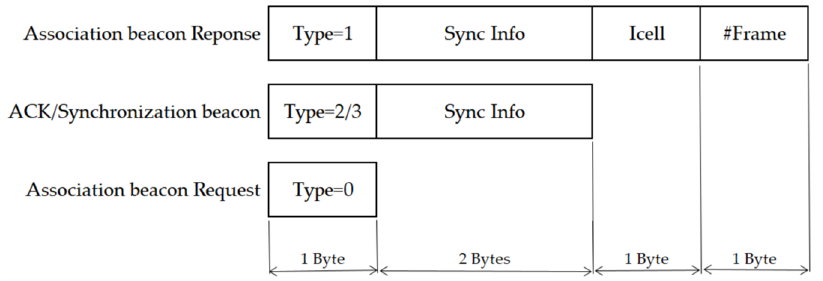
Figure 5. Beacons’ payload format.